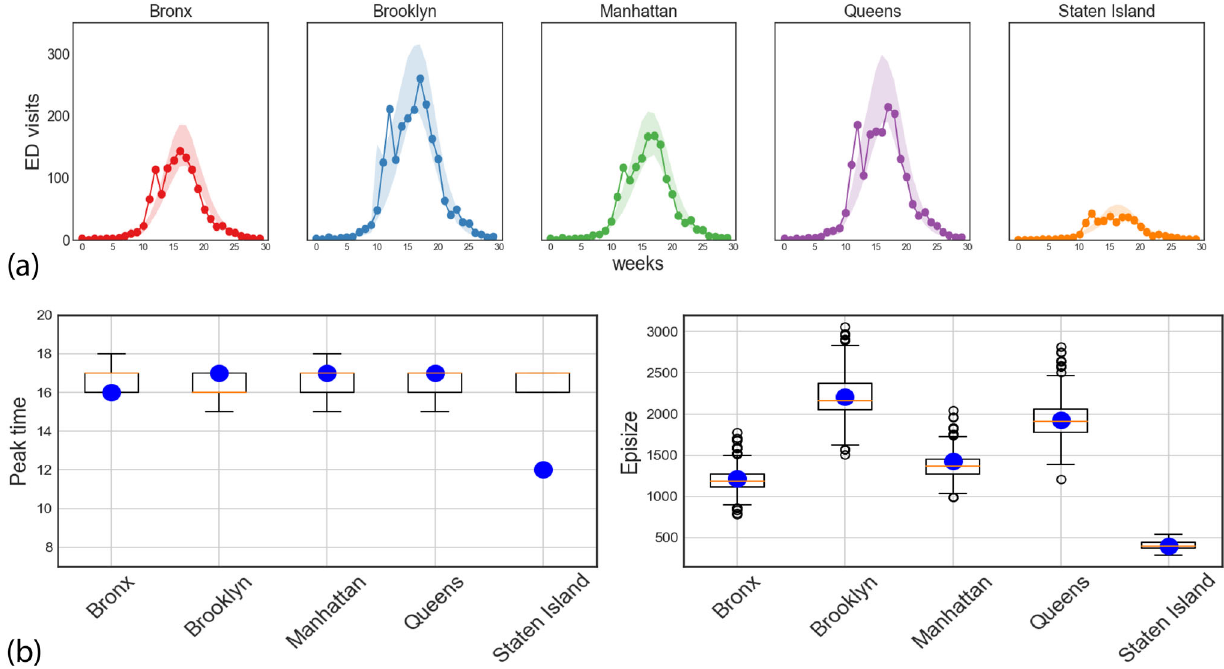
Fig. 6 Leave-one-out cross validation performance. a For each of the boroughs, the ground truth is shown in solid line along with the 90% calibrated envelope when the borough ’ s data were left out of the calibration process. b Boxplots (median, IQR, and whiskers at 1.5 IQR) of the predicted peak time and total ED visits (episize) for the left-out borough ( n = 1000), with the ground truth shown by blue dots.